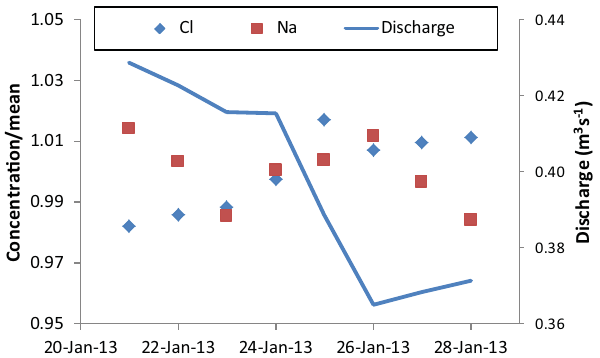
Figure 4. Major ion changes during streamflow recession of Jan- uary 2013 measured at Bunker Hill gauging station. Concentrations are divided by the mean concentration of the sampling period for each tracer.